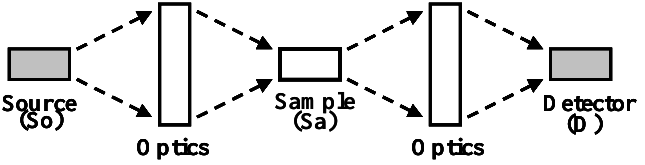
OpticsSample OpticsSample Source Detector (D)Source Detector (D)Source Detector (D)Source Detector Optics(So) (So) (Sa) Optics(So) (So) (Sa) Optics Optics Optics Optics